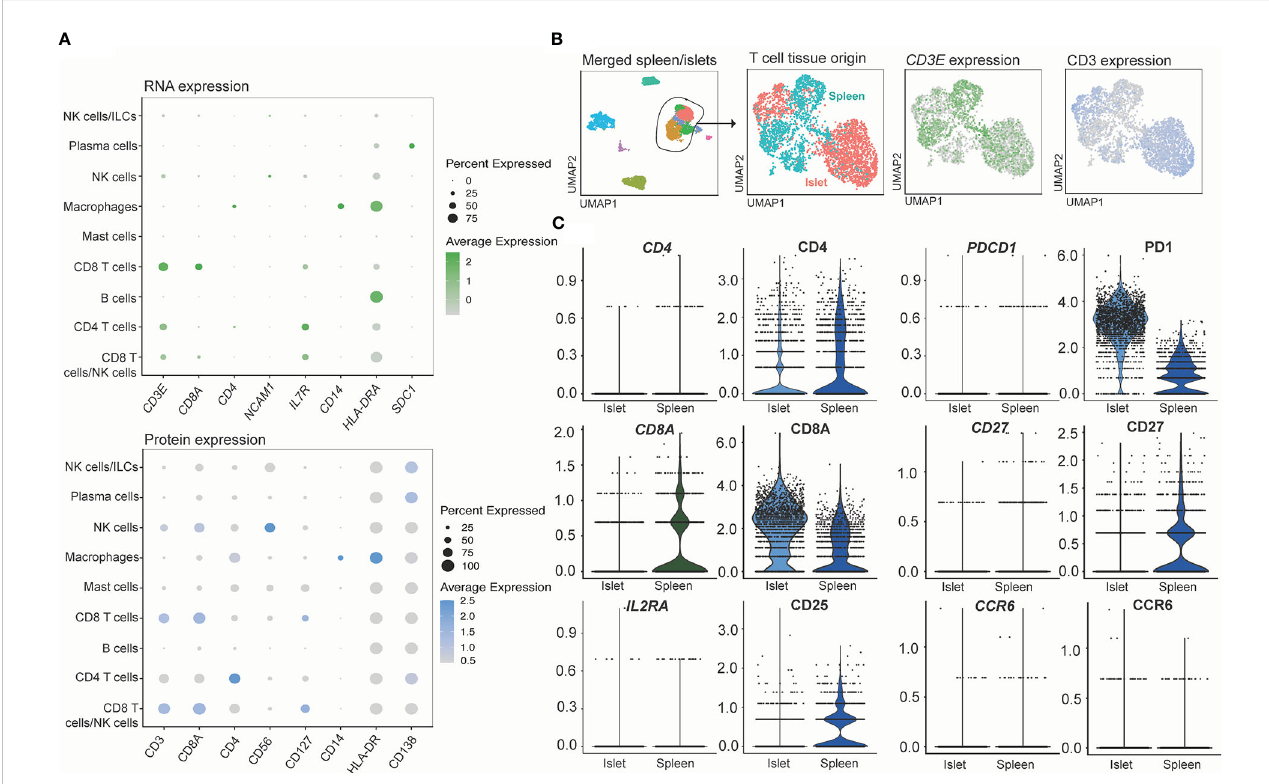
FIGURE 8 CITE-seq allows identi fi cation cell types through the expression of surface markers not captured by single cell RNA sequencing. (A) RNA (genes shown in green) and protein (surface markers shown in blue) expression of matched molecules. (B) Markers shown to be sensitive to digestion by fl ow cytometry on T cells. T cells subsets were extracted from the combined islet/spleen objects and (C) titration markers were compared between the digested (islets) and non-digested (spleen)